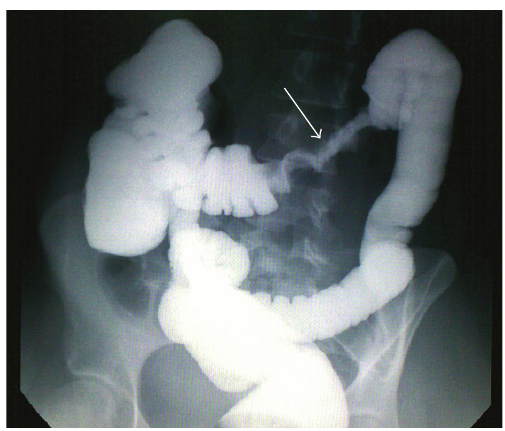
Figure 1: Barium enema showing apple core appearance and shouldering (white arrow), suggestive of colon cancer.